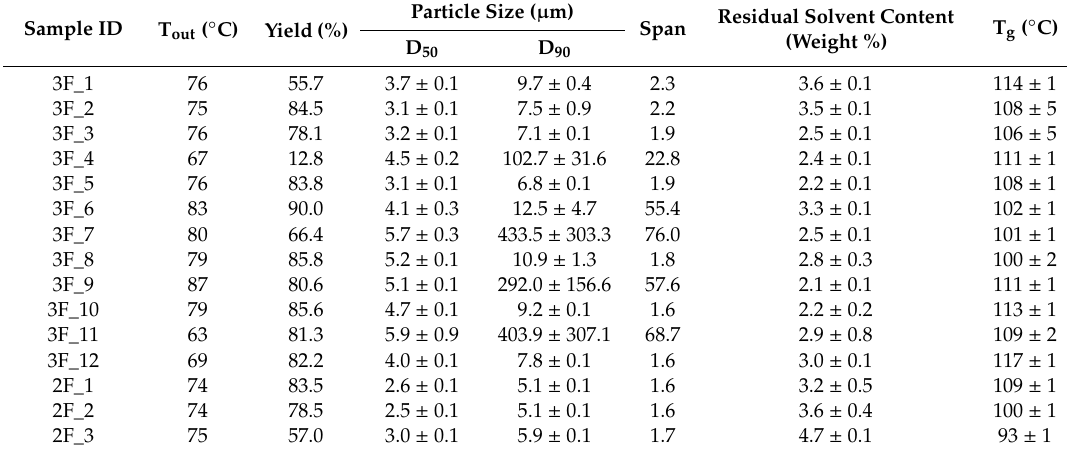
Table 2. Main physical characteristics of spray-dried